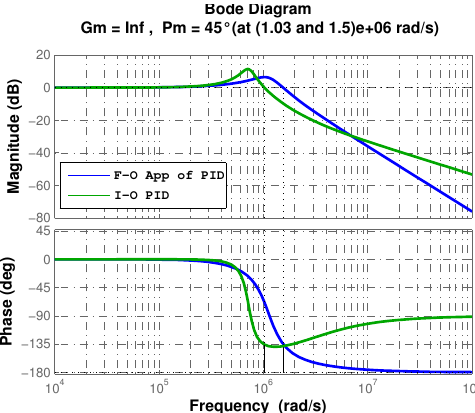
Figure 6. Frequency response of closed-loop transfer function of a Buck converter when using integer–order PID (green) and fractional-order PID